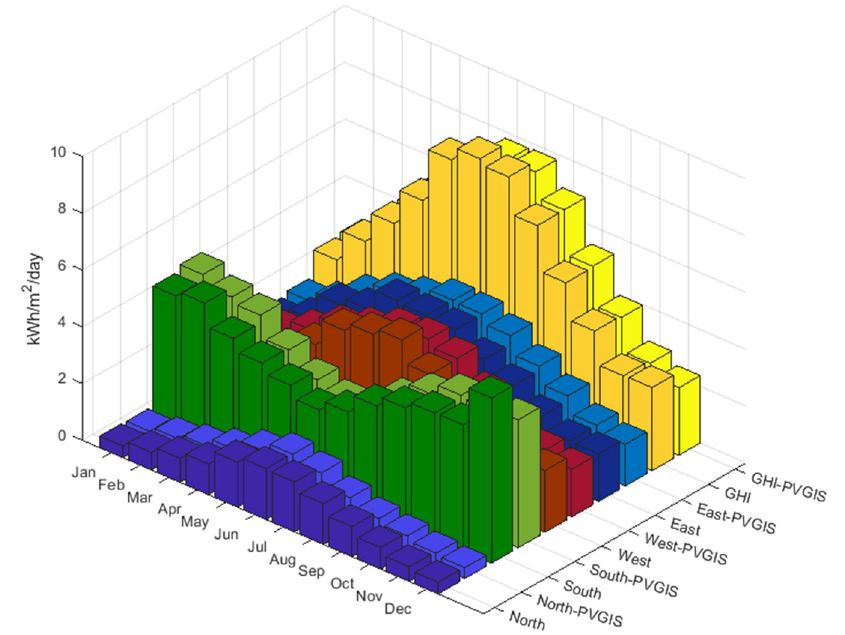
Figure 8. Monthly average of daily irradiation (kWh / m 2 / day). PVGIS-SARAH database and measured data for the year 2018.